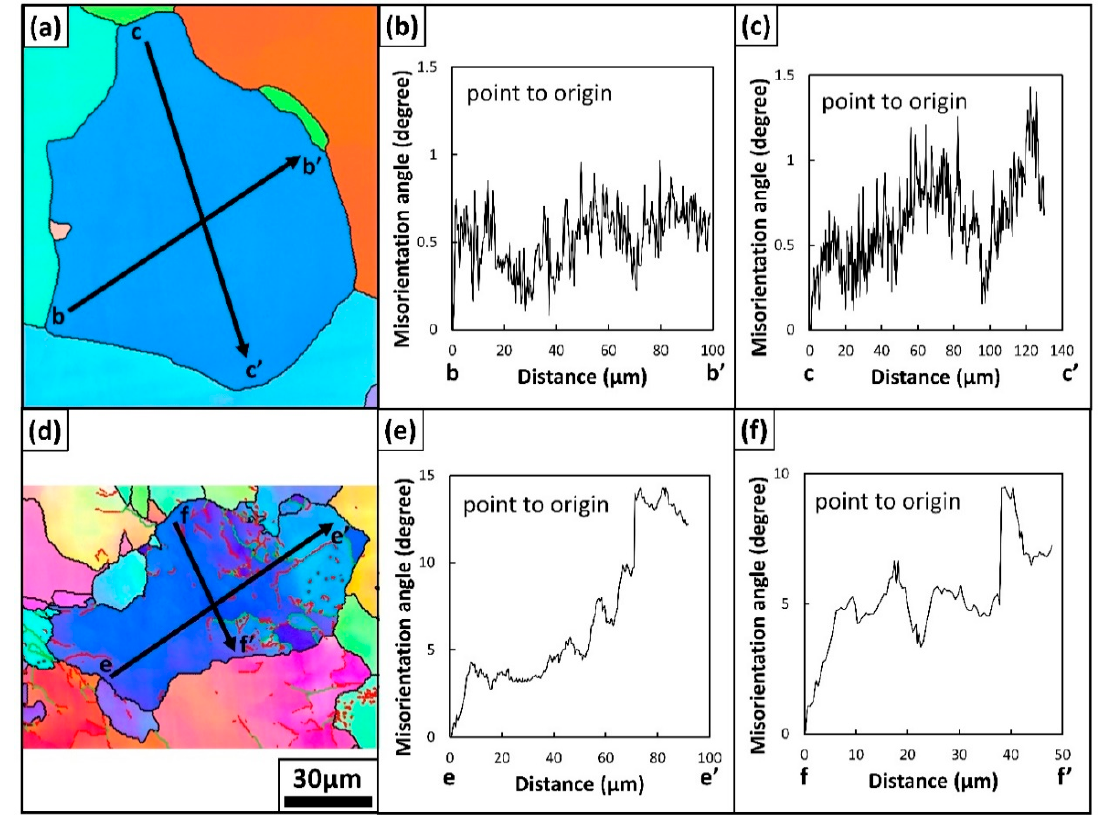
Figure 4. Misorientation line profiles of ( a – c ) allotriomorphic ferrite and ( d – f ) massive ferrite in Steel A, showing the accumulated point-to-origin orientation differences.